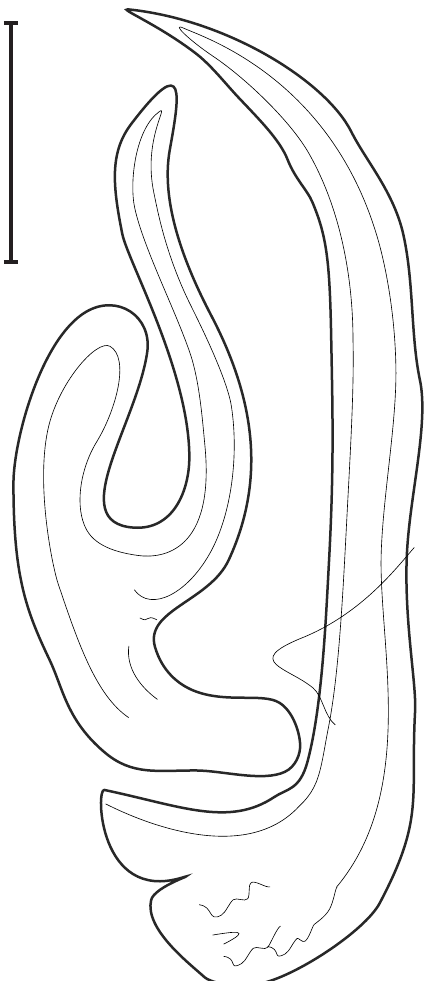
Fig. 3. – Lamellodscus sanfilippoi n. sp. Morphologie des pièces sclé- rifiées de l’appareil copulateur mâle. Échelle : 10